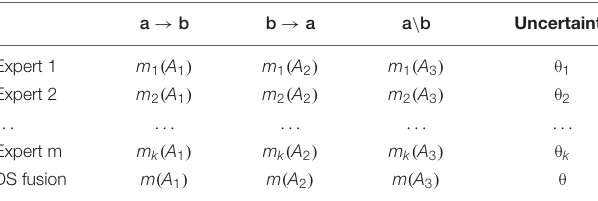
TABLE 2 | Credibility distribution of structure connection with m